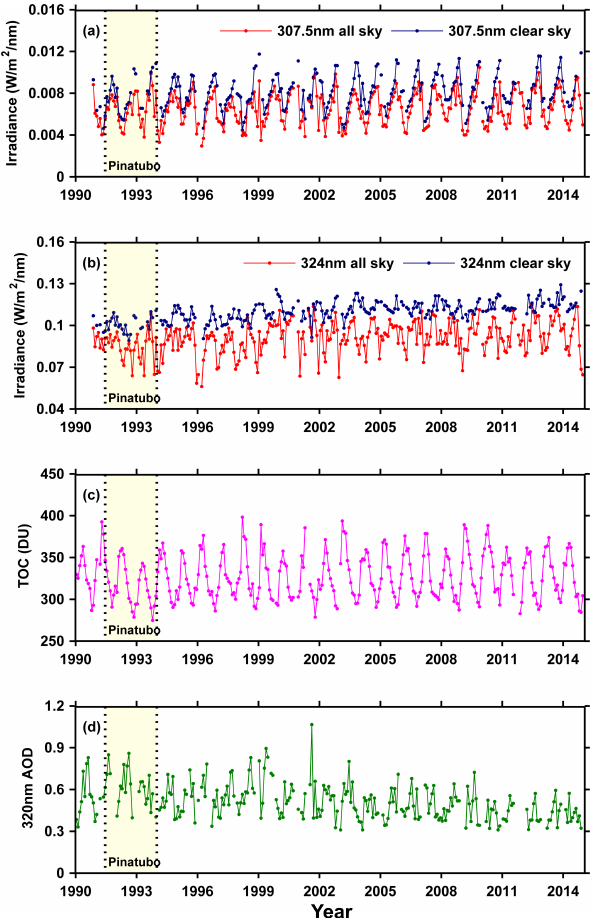
Figure 1. Time series of monthly mean all-sky and clear-sky irradi- ance at 63 ◦ ( ± 1 ◦ ) SZA for (a) 307.5nm and (b) 324nm. Monthly means derived from daily means are shown in (c) for TOC and (d) for AOD at 320nm. Monthly means were calculated only for months with at least 10 days of